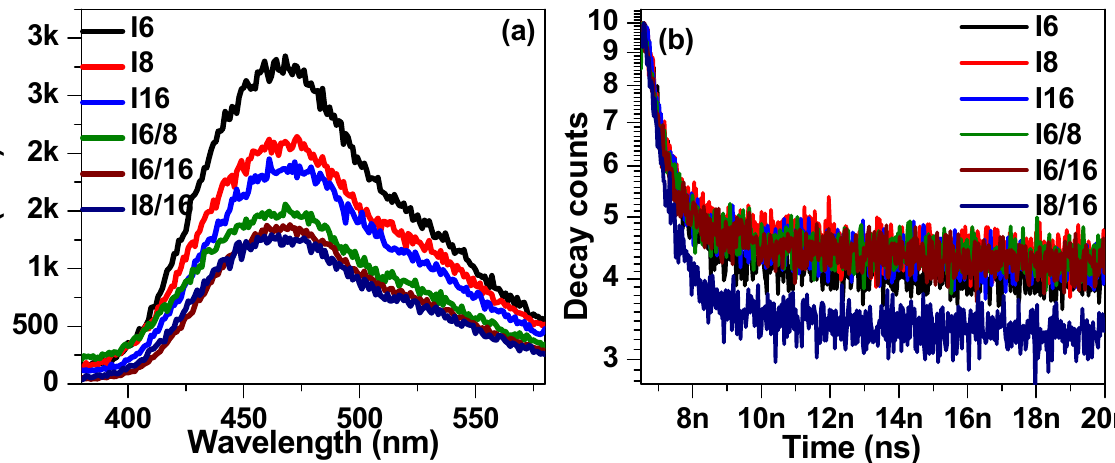
Figure 8. The steady-state ( a ) and time-resolved ( b ) PL spectra of investigated materials In in pure and mixed states. Table 2. The optical parameters evaluated from absorbance and fi tt ing of time-resolved fl uores- cence spectra.